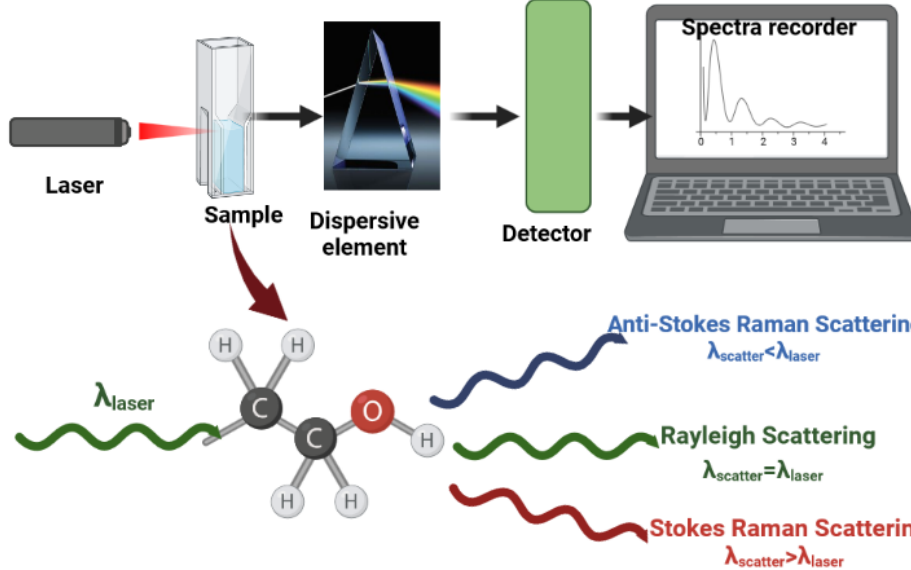
Figure 6. Raman spectroscopy principle (Created in BioRender.com) .